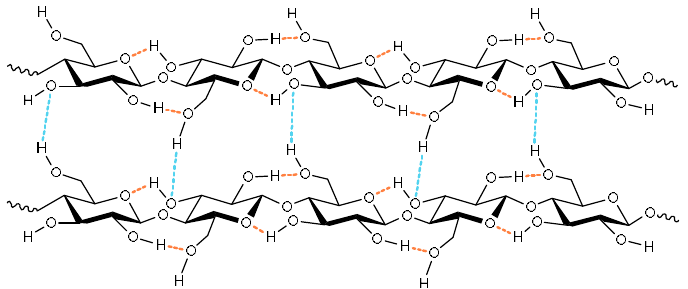
Figure 5. Hydrogen bonds present in cellulose structure.